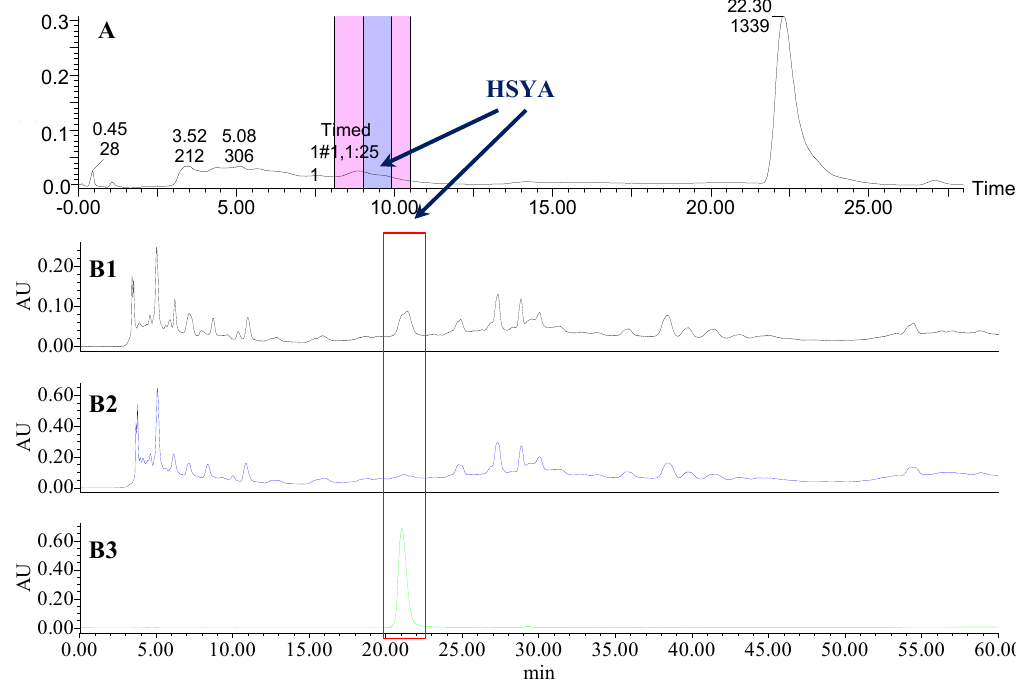
0.000.100.20 AU